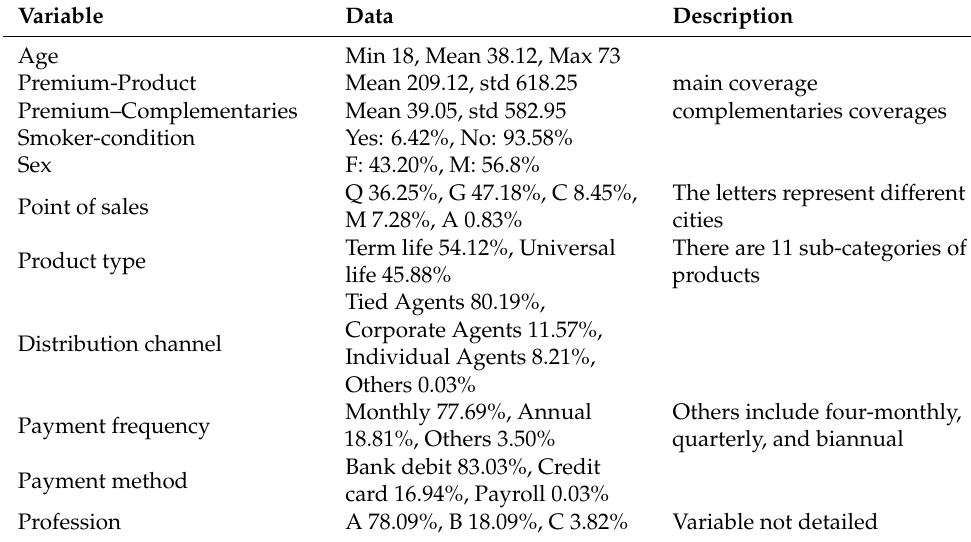
Table 4. Description of Explanatory Variables.